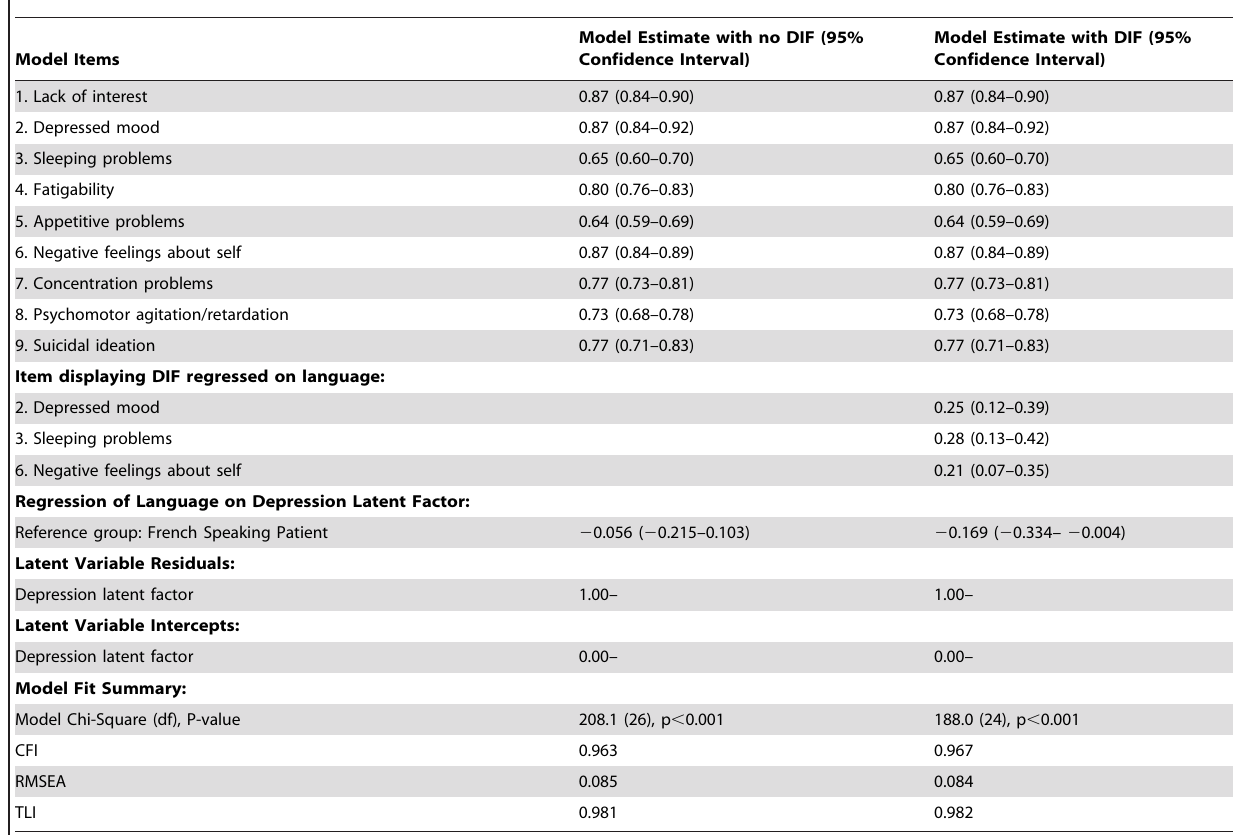
Table 2. Baseline and Final Model Characteristics with Summary Measures Of Model Fit.